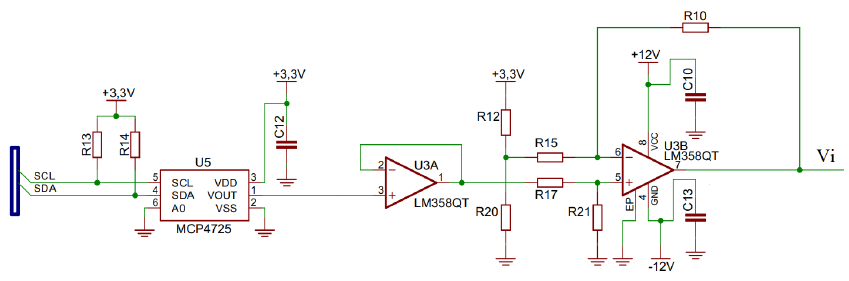
Figure 5. D/A converter and zero-reference adjustment circuit.